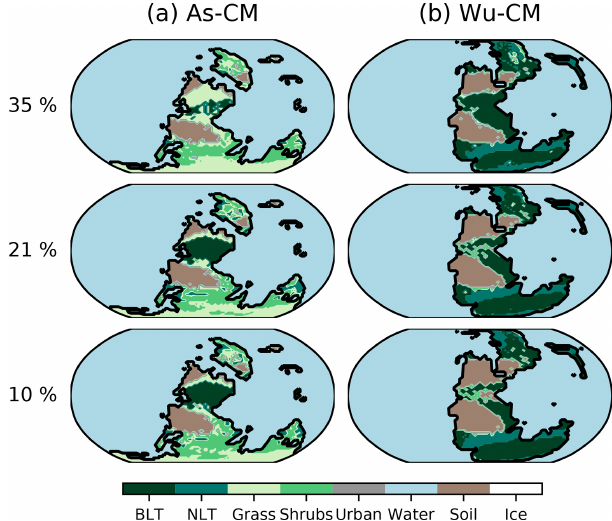
Figure 13. Dominant surface type for each oxygen level simulation for (a) As-CM and (b) Wu-CM. BLT: broadleaf tree; NLT: needle- leaf